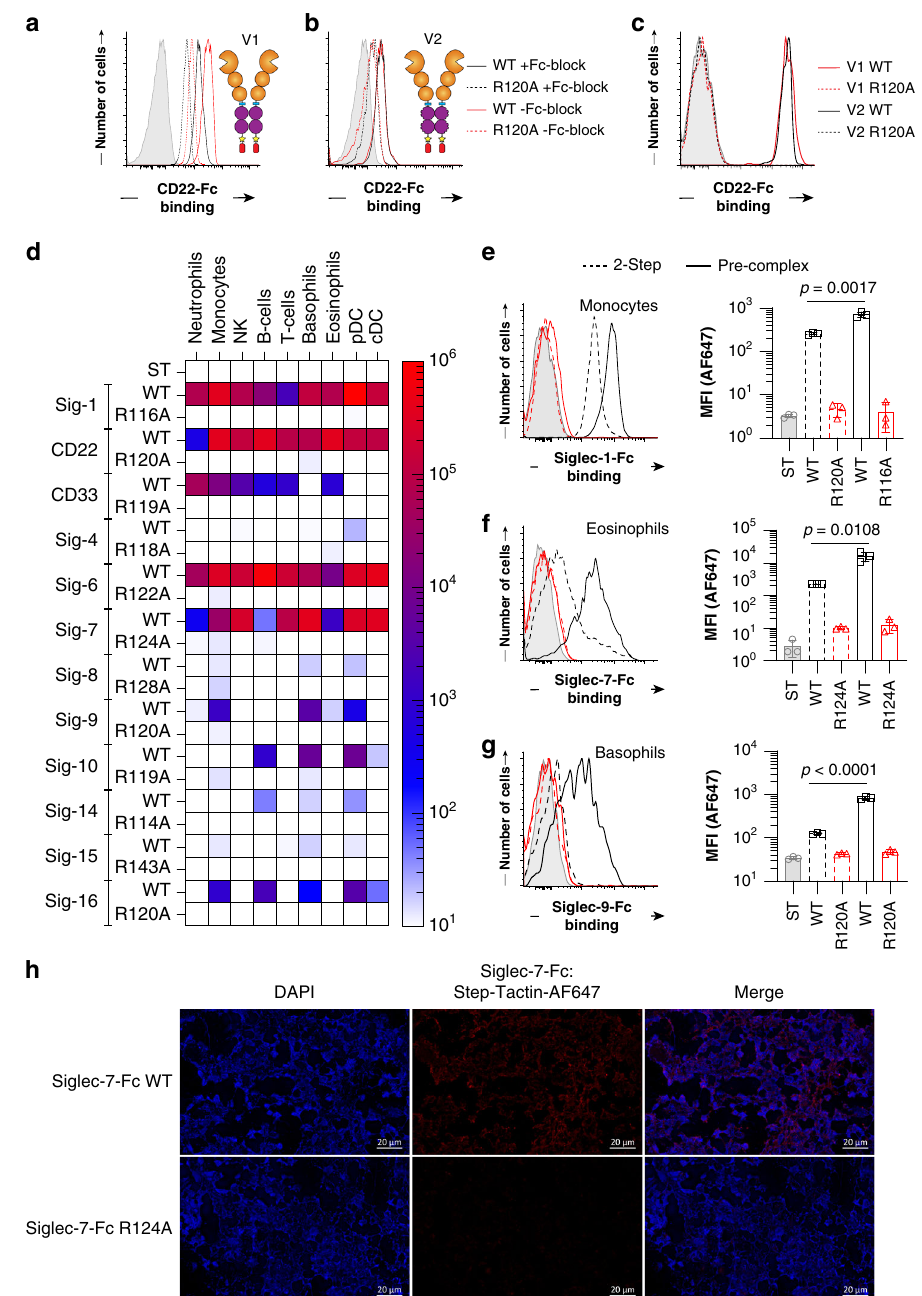
Fig. 3 Pro fi ling Siglec ligands on primary human immune cells. a Binding of CD22-Fc V1 WT (red) and R120A mutant (black) to neutrophils that were pretreated with Fc receptor block (dashed) or without (solid) followed by staining with Strep-Tactin-AF647. Control staining (gray) is Strep-Tactin-AF647 alone. b Binding of CD22-Fc V2 WT (red) and R120A mutant (black) to neutrophils that were pretreated with Fc receptor block (dashed) or without (solid). c CD22-Fc V1 (red) or V2 (black) binding to B-cells. d Flow cytometry data of Siglec-Fc constructs that bound after pre-complexing with Strep-Tactin-AF647 to B-cells (CD19 + ), T-cells (CD3 + ), NK cells (CD56 + ), monocytes (CD14 + ), neutrophils (CD15 + ), eosinophils (Siglec-8 + ), basophils (CCR3 + ), pDCs (CD123 high /HLA-DR + ), and cDCs (CD123 dim /HLA-DR + ). e – g Binding to the indicated WT (black) and arginine mutant (red) Siglec-Fc to e monocytes, f eosinophils, and g basophils in either a 2-step assay (dashed) or pre-complexed assay (solid). h Immuno fl uorescence staining of human spleen with Siglec-7-Fc WT or Siglec-7-Fc R124A. Immuno fl uorescent staining was repeated three times with similar results. Error bars represent ±standard deviation of three replicates. Statistical signi fi cance calculated based on a two-tailed unpaired Student ’ s T -test.